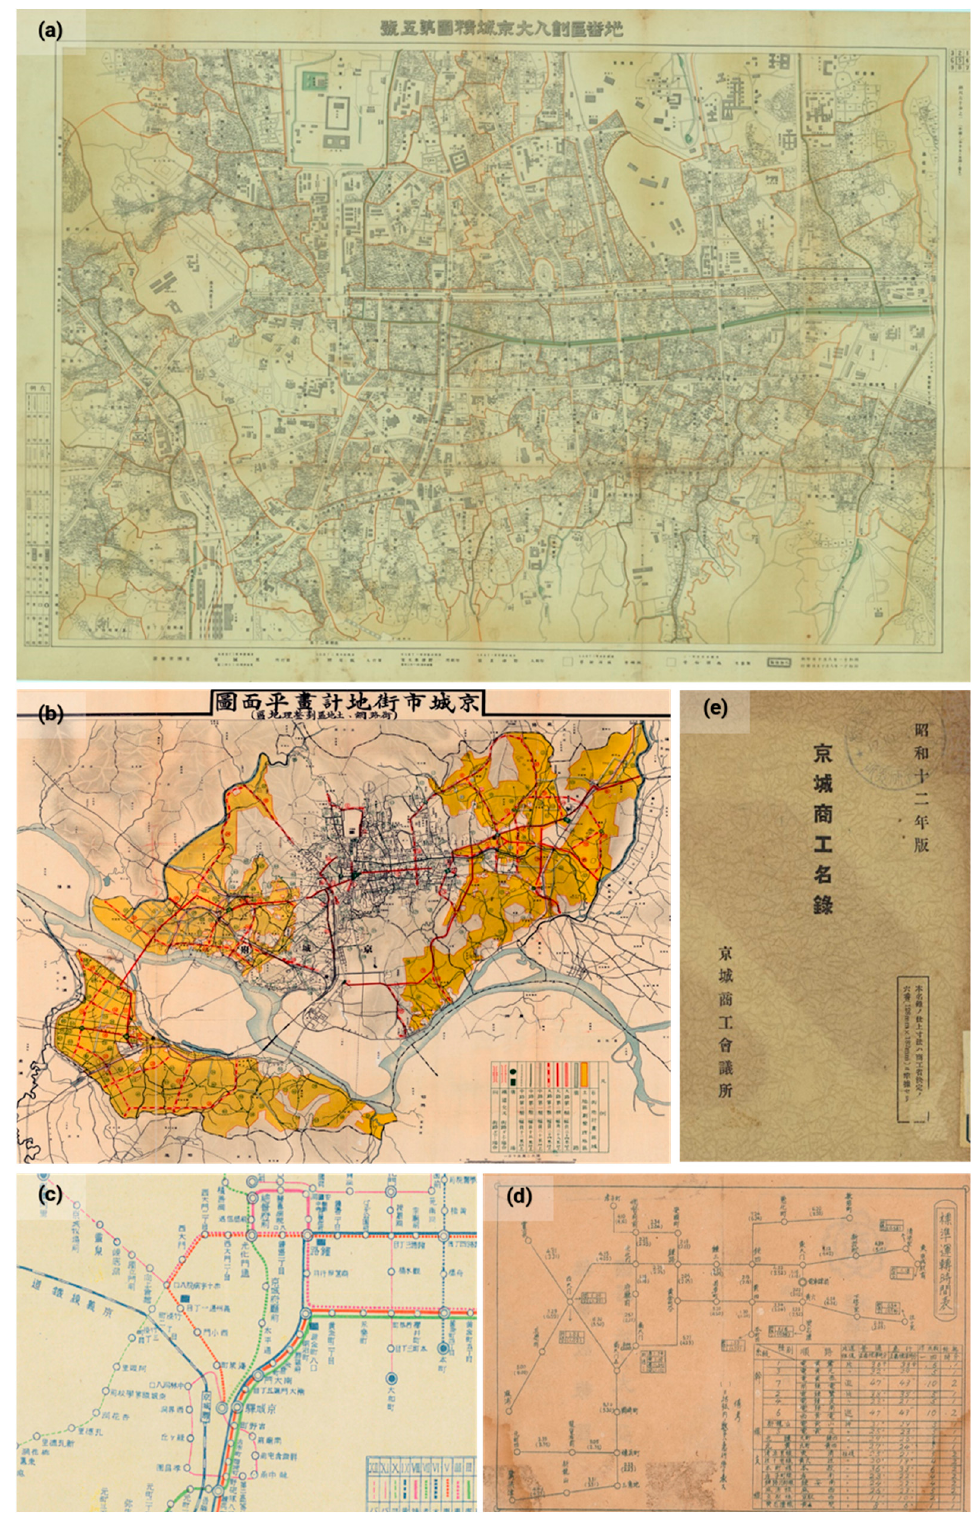
Figure 2. Historical materials used for the study. ( a ) Map of Greater Keijo (1936); ( b ) Keijo Urban Planning Map (1938); ( c ) Keijo Tram and Bus Route Map (mid-1930s); ( d ) Keijo Tram Operation Timetable (1942); and ( e ) Keijo Business Demography Index (1938). (Note. Keijo indicates colonial Seoul, which is our study area).